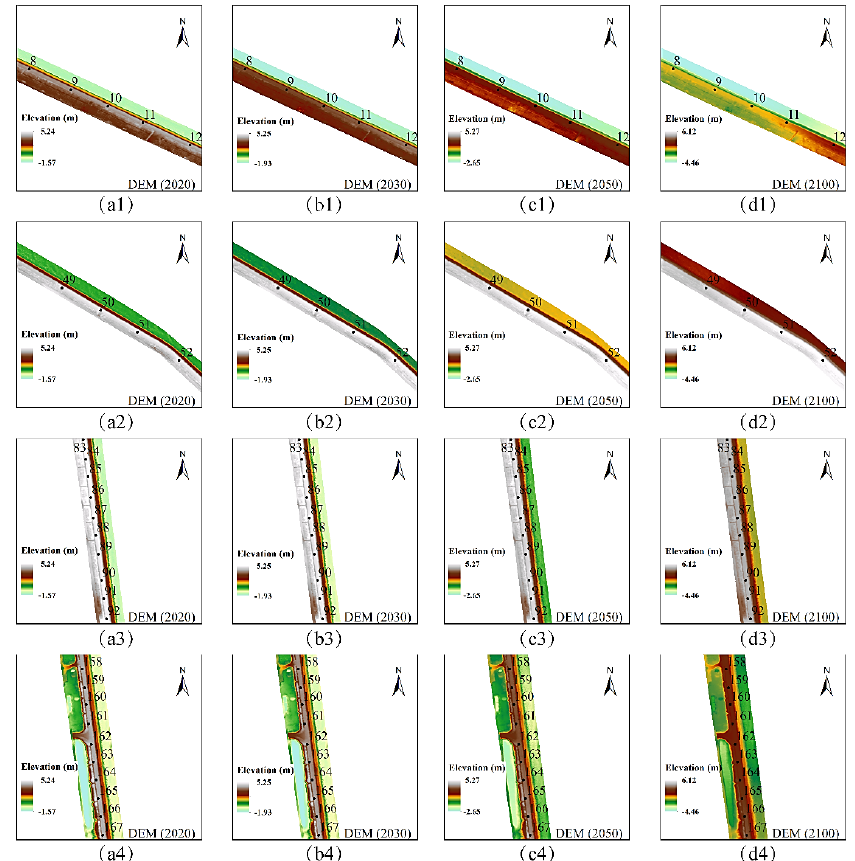
Figure 21. DEM changes superposed with the dam deformation for four fragments of Gudong Dam